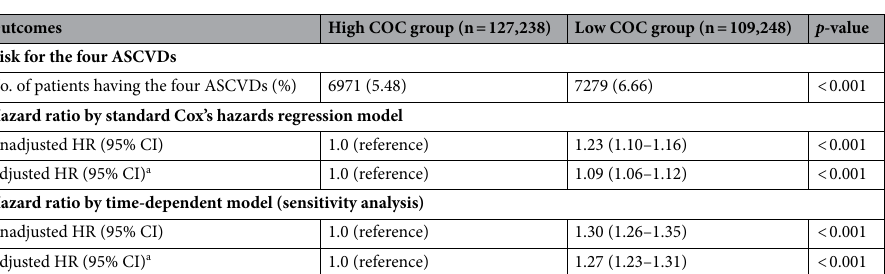
Table 3. Risks for the four ASCVDs from Cox’s hazard regression models in Korean dyslipidemia patients. ASCVD atherosclerotic cardiovascular disease, CI confidential interval, COC continuity of care, HR hazard ratio, IQR interquartile range, SD standard deviation. a The adjusted HR was analyzed after adjusting for covariates including sex, age, insurance contribution, payer, urbanization level of residence, comorbidity as Elixhauser score and antihyperlipidemic agent use.